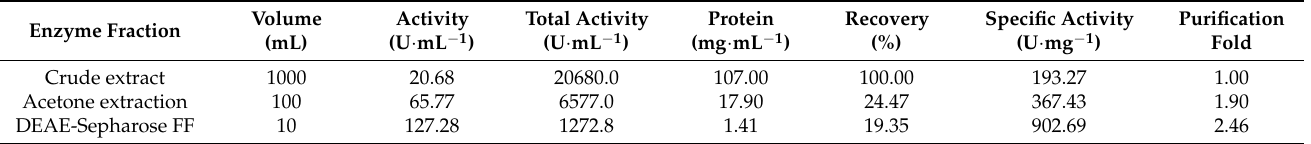
Table 1. Purification process of mannanase from W. cibaria